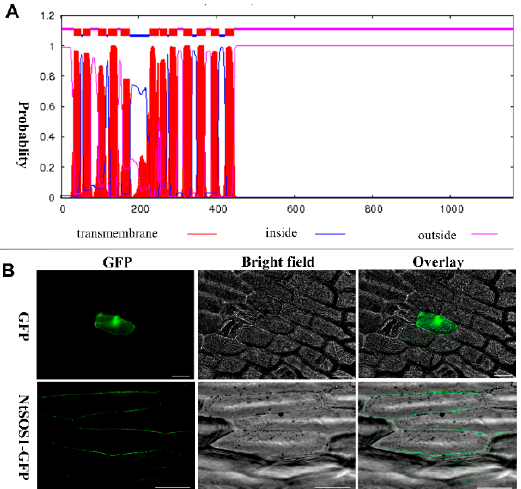
Figure 14. Subcellular localization of NtNHX7. ( A ) NtNHX7 transmembrane helix domain prediction by TMHMM. ( B ) NtNHX7 subcellular localization by microprojectile bombardmen, 35S: GFP plants as control. Scale bar =100 μ m.